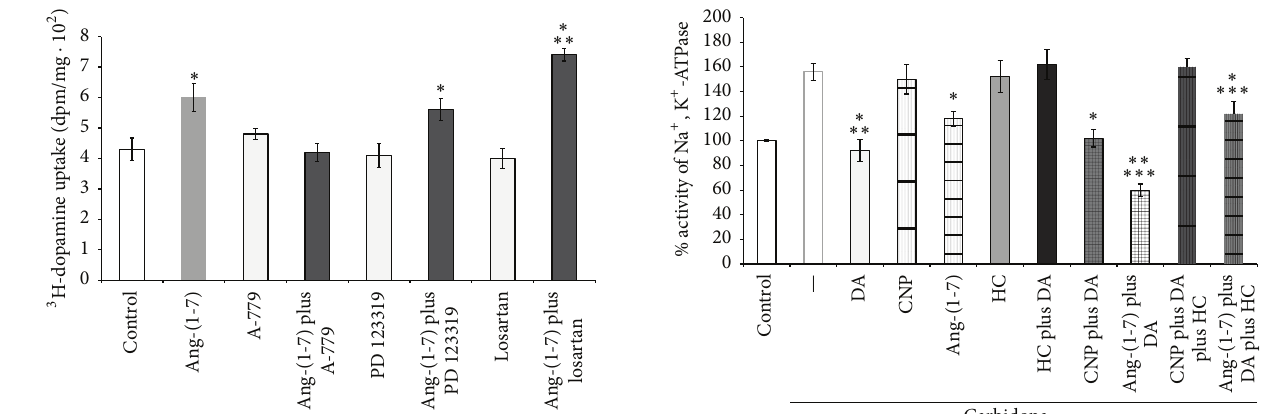
Figure 7: Effects of CNP, Ang-(1-7), dopamine (DA), and hydrocor- tisone (HC) on Na + , K + -ATPase activity, calculated as percentage of Na + , K + -ATPase activity of control values ± SEM in renal cortex. The experiments were carried out in the absence (control) or in the presence of carbidopa. ∗ 𝑝 < 0.01 compared with carbidopa alone; ∗∗ 𝑝 < 0.05 compared with Ang-(1-7); ∗∗∗ 𝑝 < 0.05 compared with dopamine. Number of samples: